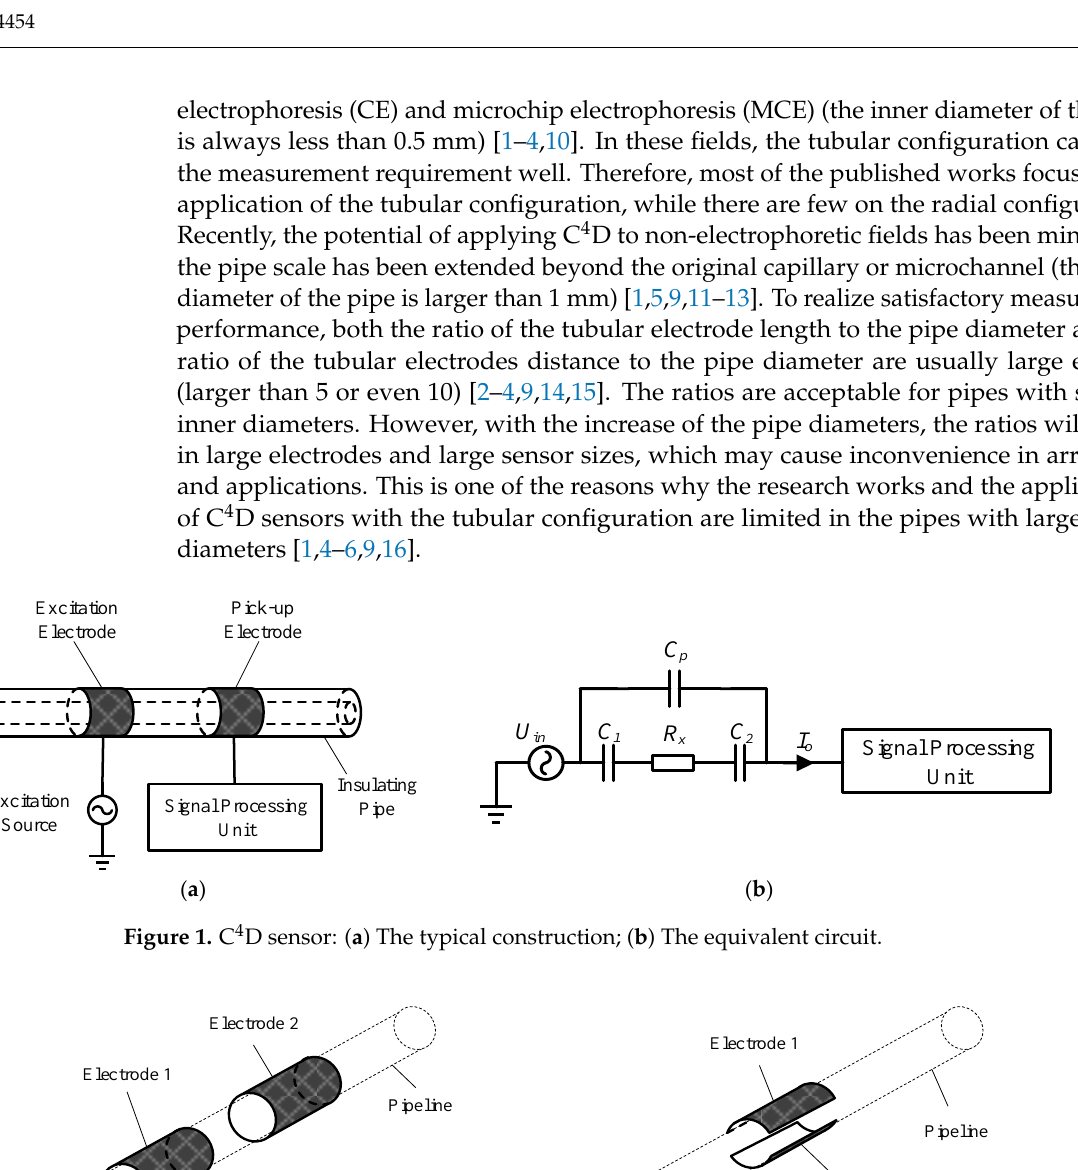
( b ) Figure 2. The C 4 D sensor with different electrode configurations: ( a ) Tubular configuration; ( b ) Radial configuration. No- tation: For the tubular configuration (as illustrated in ( a )), a pair of cylindrical electrodes is attached around the pipe. For the radial configuration (as illustrated in ( b )), a pair of concave electrodes is attached to the pipe oppositely. Radial configuration provides another effective application for C 4 D. Radial configu- ration is more compact than tubular configuration so it is applicable for normal-scale (mil- limeter or tens of millimeter scale) pipes and can avoid the aforementioned defects of the tubular configuration [5,9,17]. Furthermore, for sensors with radial configuration, the fluid is measured in the radial direction of the pipeline. This characteristic is different from